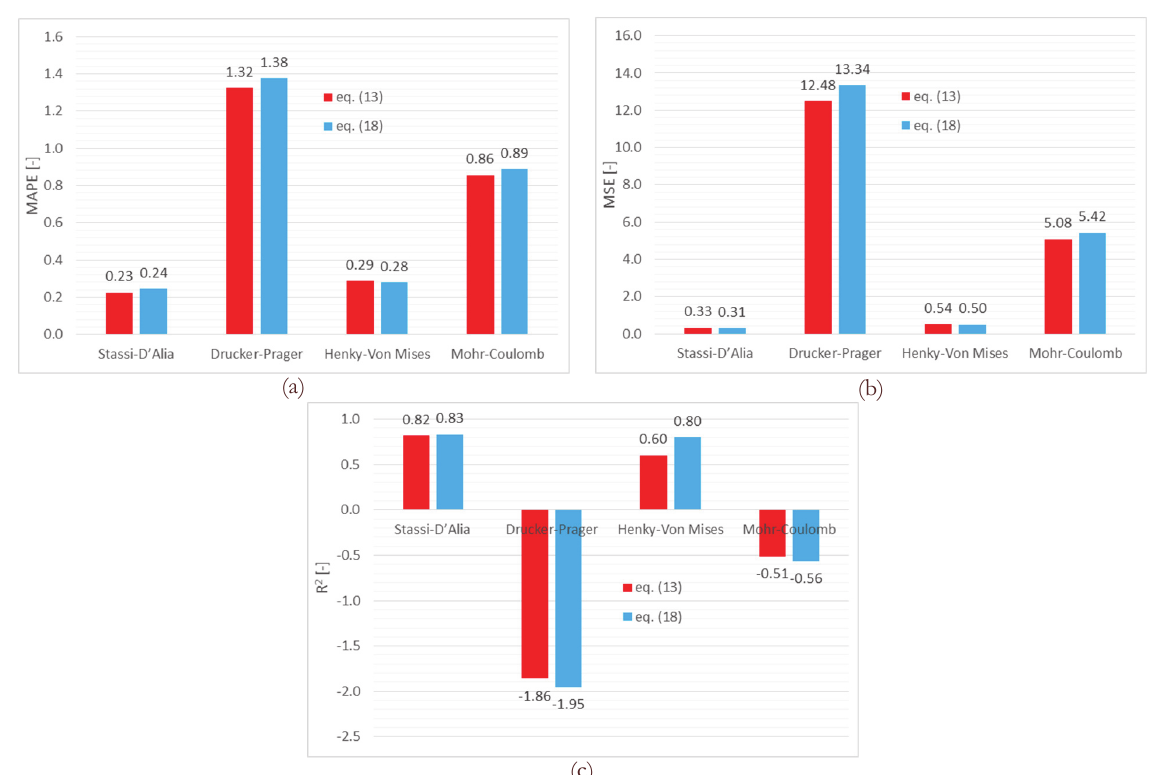
f : a) MAPE, b) MSE and c) R 2 , l eff